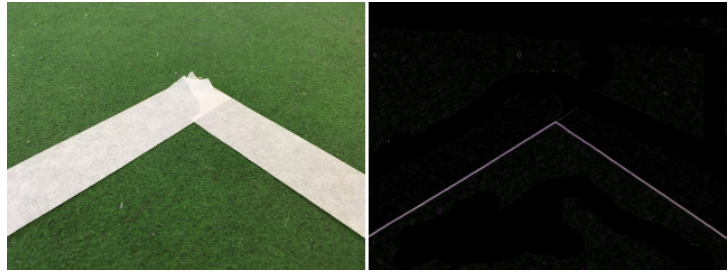
Figure 6. 2D image edge